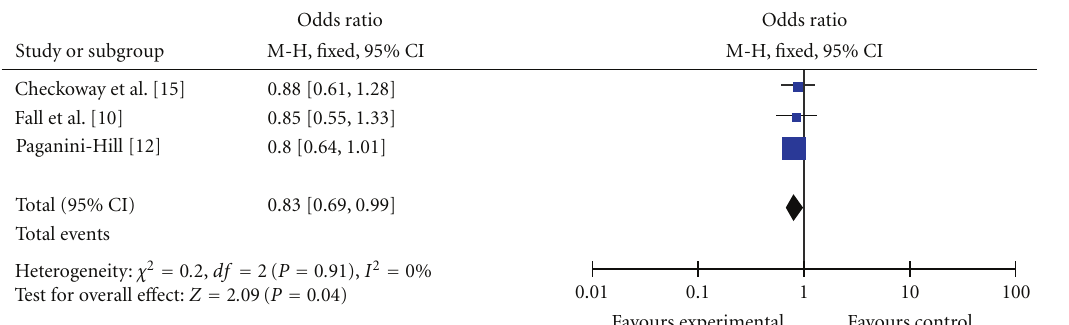
Figure 3: Pooled estimate of OR and 95% CI of PD risk for tea drinking of ≤ 1 cup per day. Blue diamonds indicate adjusted OR in each study. Open diamonds are pooled OR. Horizontal line represents 95% CI. Studies are ordered by alphabetical order of the last name of first author.